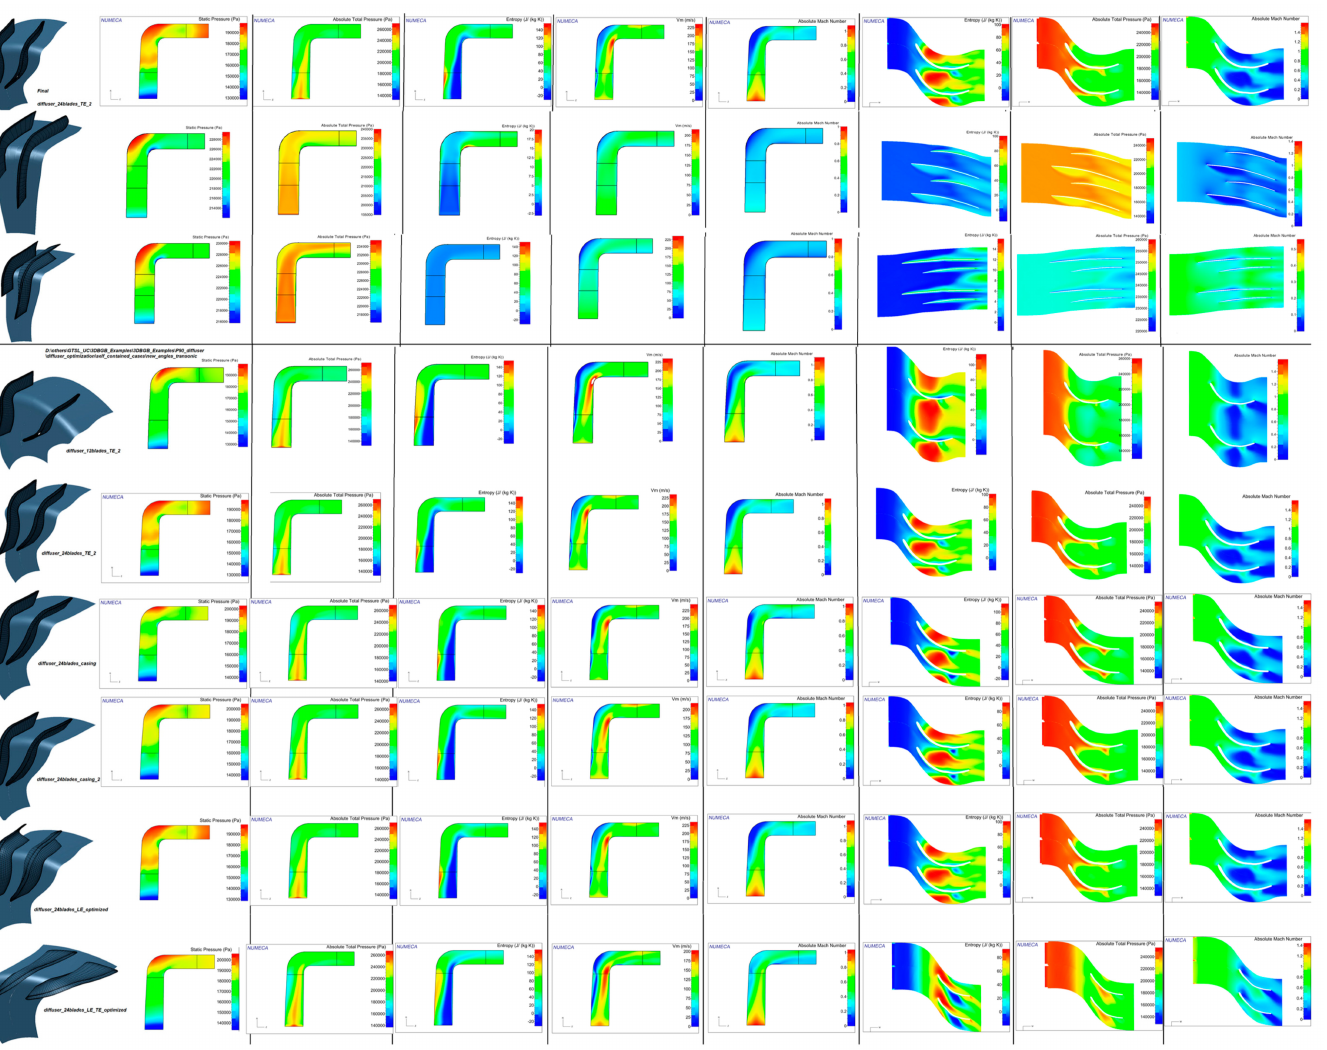
Figure A1. Automated post-process of flow properties from 3D RANS solution in axisymmetric view and 50% span for full-bladed and splittered diffuser